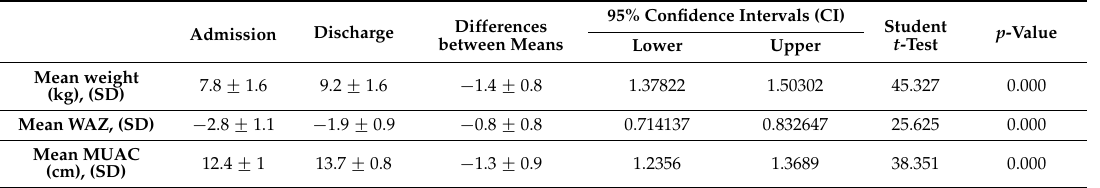
Table 3. Differences between means of the anthropometric parameters at admission and discharge in recovered children ( n = 709), and Student’s t -test.